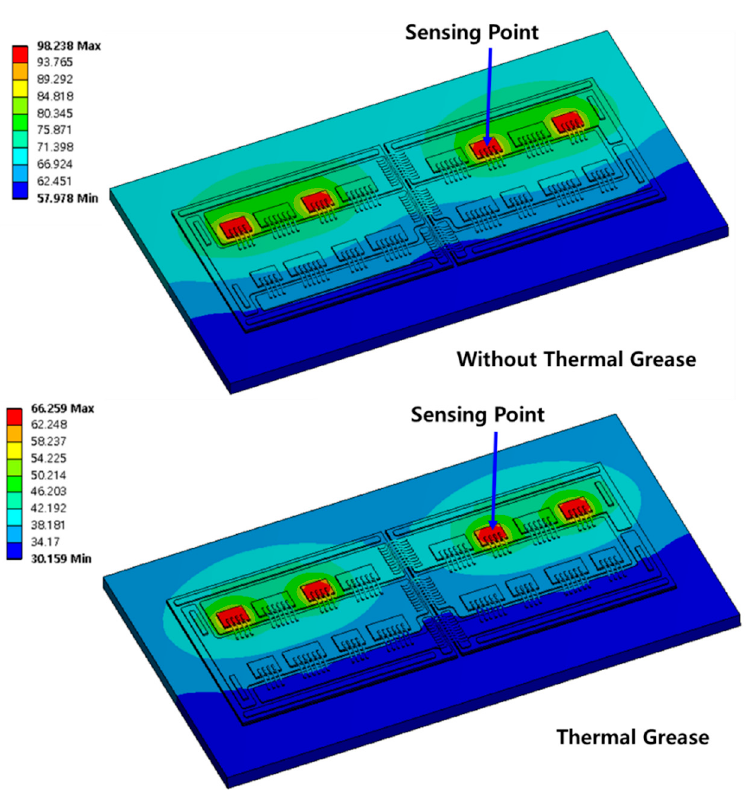
Figure 5. Thermal simulation results (with and without thermal